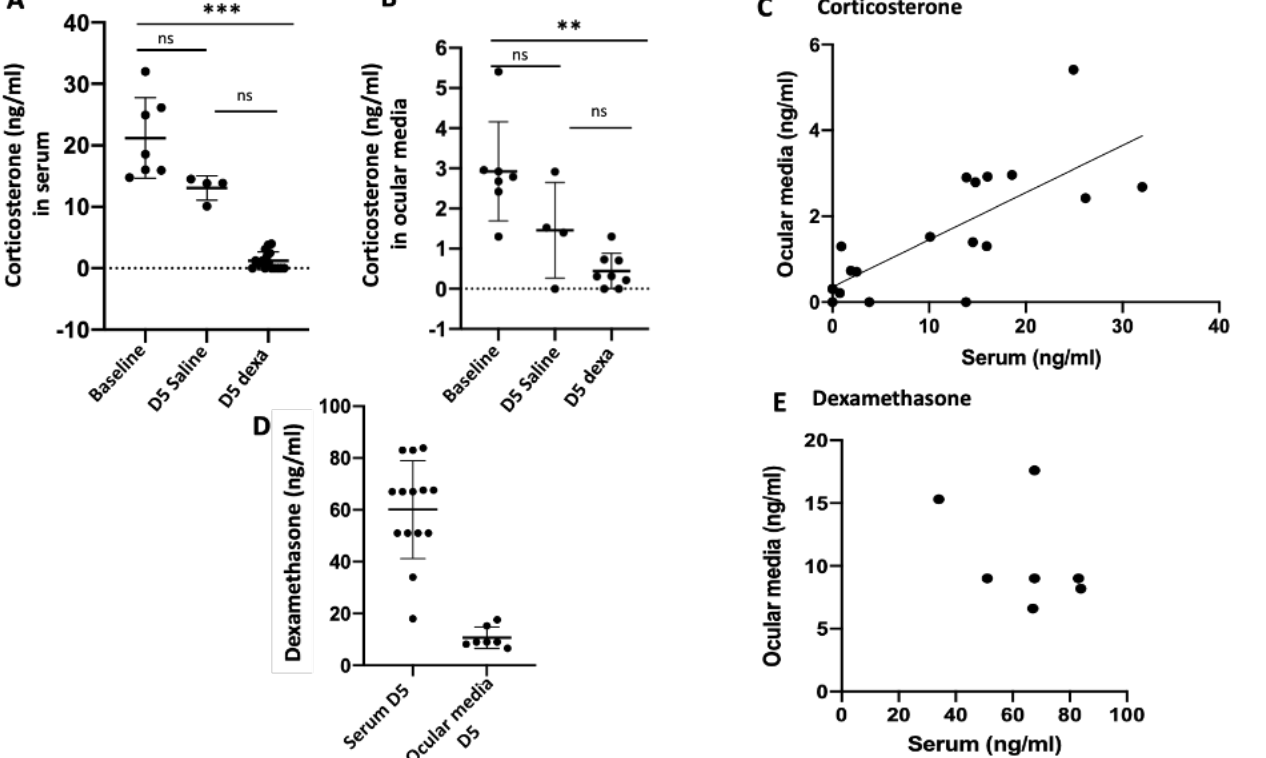
Figure 1. Corticosterone and dexamethasone levels in the rat serum and ocular media. Corticosterone in the serum ( A ) and ocular media ( B ) at baseline ( n = 7) and after 5 days of daily injection of dexamethasone (D5) ( n = 16) or saline ( n = 5). Spearman correlation between corticosterone ocular and serum levels (r = 0.76, p = 0.0001) ( C ). Dexamethasone serum ( n = 14) and ocular media ( n = 7) after 5 days of daily injection of dexamethasone ( D ). Spearman correlation between dexamethasone ocular and serum levels (r = − 0.28, p = 0.55) ( E ), ** p < 0.001, *** p < 0.0001, ns non significant.